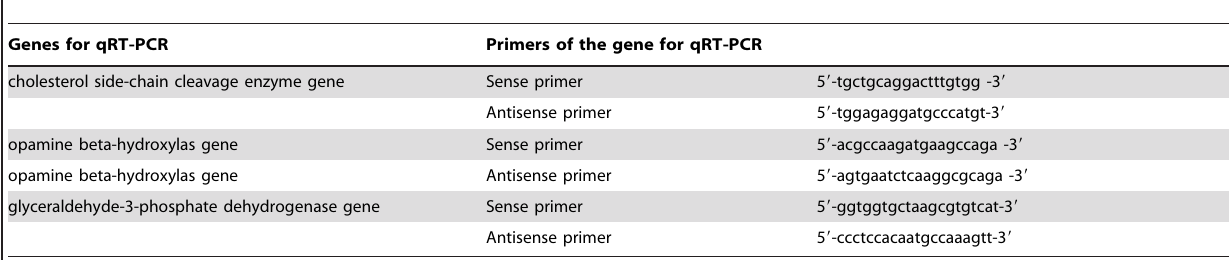
Table 1. Primers used in qRT-PCR for validation of differentially expressed genes.